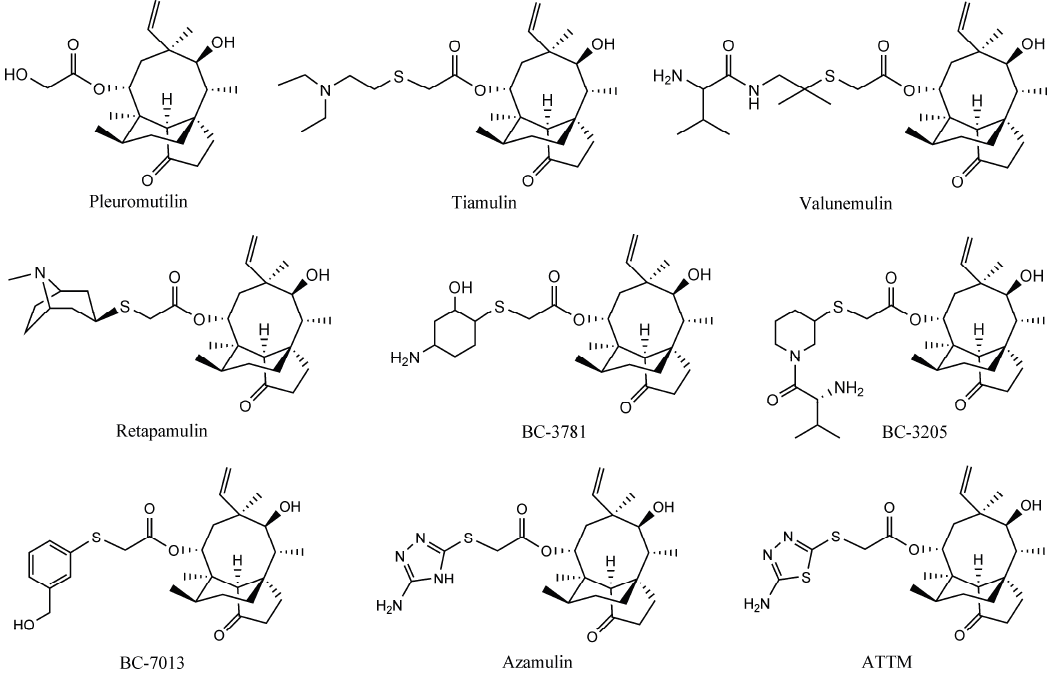
Figure 1. The structures of the pleuromutilin derivatives and